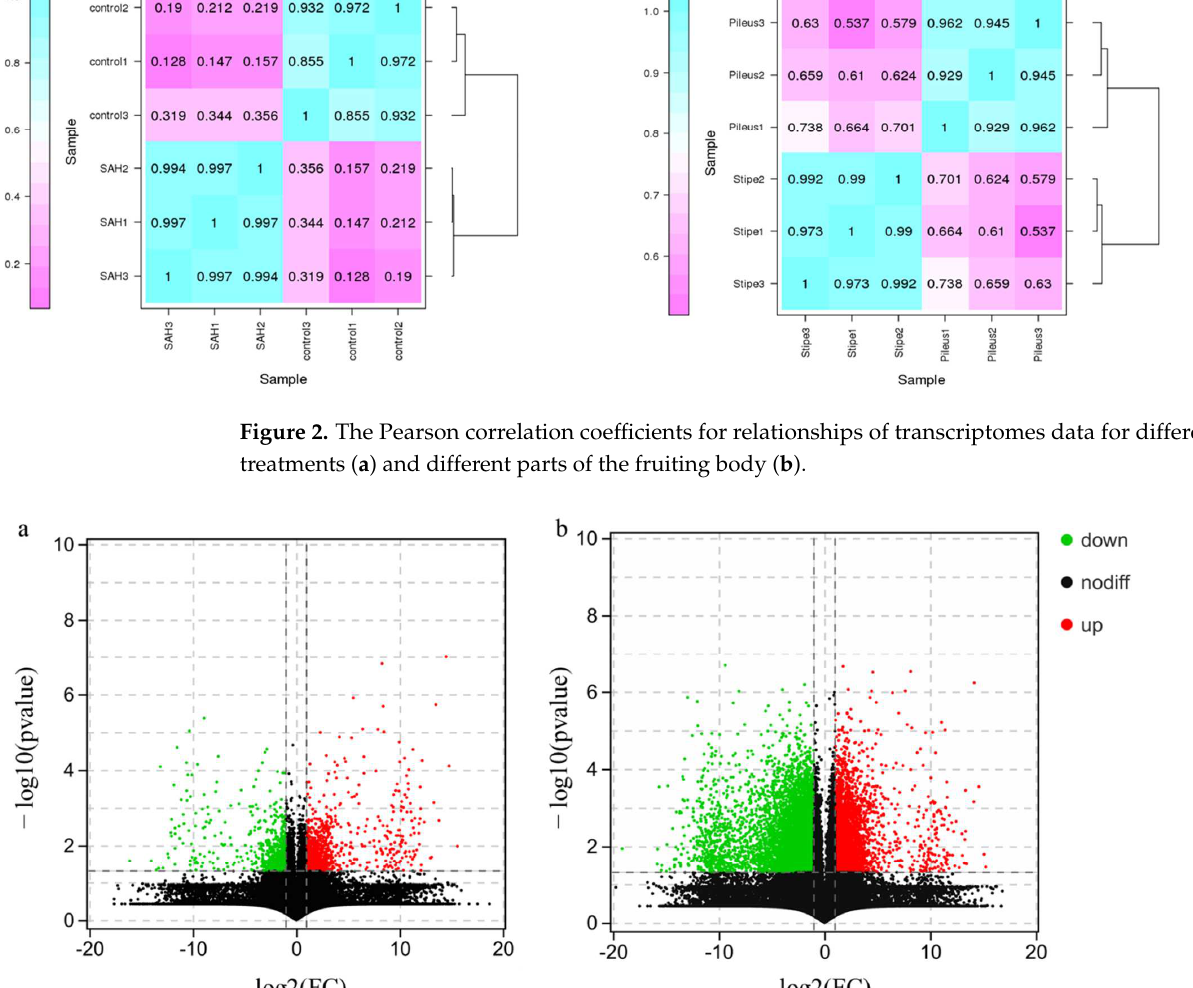
Figure 2. The Pearson correlation coefficients for relationships of transcriptomes data for different treatments ( a ) and different parts of the fruiting body ( b ).